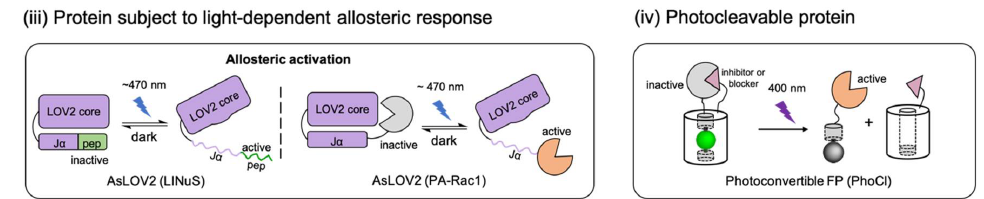
Figure 1. A schematic overview of the photosensory modules in actuators and their representative applications. Proteins are classified by different light-induced responses and labeled with their natural sourced photoreceptors. ( i ) Opsin-based light-activatable transmembrane protein include microbial rhodopsins and G-protein couple receptor (GPCR) rhodopsins. ( ii ) Light-induced homo-dimerization, homo-oligomerization, or hetero-dimerization is enabled by the interactions of light-oxygen-voltage-sensing domain (LOV) domains, cytochromes, phytochromes or photoswitchable fluorescent protein (FP) with their binding partners. ( iii ) Activity of the biofunctional module in actuator can be modified by light-induced allosteric response of LOV domains. ( iv ) Photocleavable protein (PhoCl) engineered from a photoconvertible FP enables the covalent caging of biofunctional module that can be activated irreversibly by light. The schematic representations in this figure are inspired and adapted from previously reported studies, which are labelled in parentheses below the corresponding schematic. The citations are as follow: ChR2 [2,34,35]; eNpHR [2,34,36]; eBR [34,37]; OptoXR [2,34,38]; LightOn [24]; CRY2oligo [44,45]; Dronpa145N [46]; Magnets [18,47,48]; TULIPs [49];